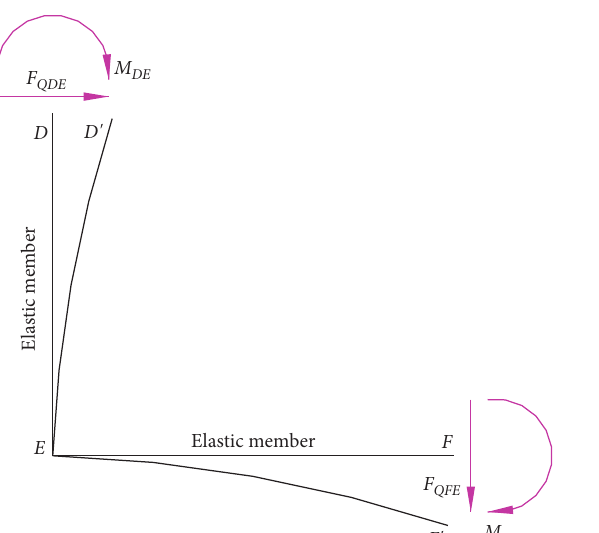
Figure 6: Structural stress of DEF (elastic combination). Due to the shear force and bending moment of the ends in the elastic members, angular displacement and lateral deflection deformations of the ends will